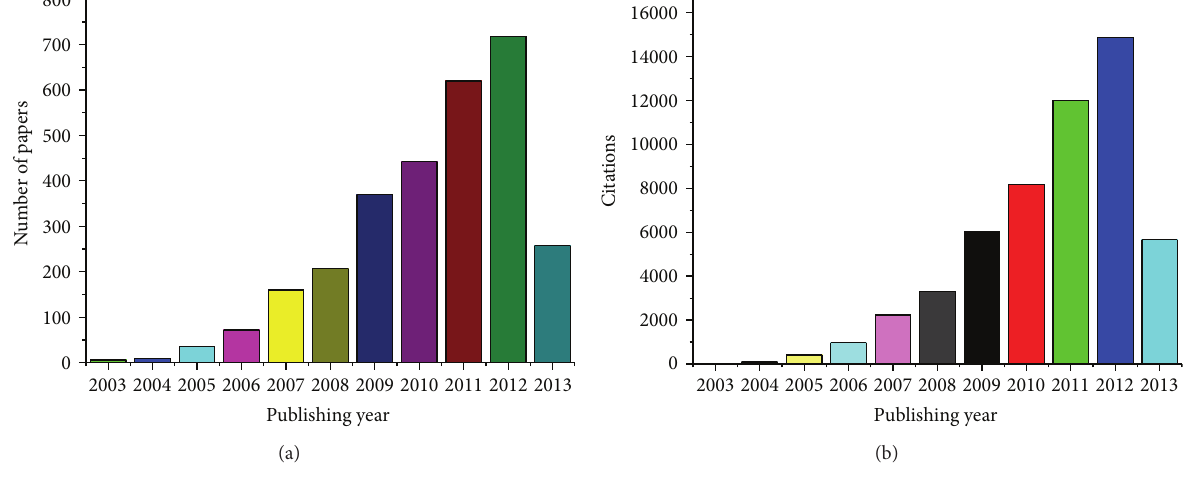
Figure 2: The number of articles (a) published on TNAs formed by electrochemical anodization and corresponding aggregated citations (b). (Statistics analysis was obtained from web of science database on May 30, 2013). Topic: TiO 2 nanotube, with the exclusion of nanotube formed by hydrothermal, sol-gel, and template or carbon